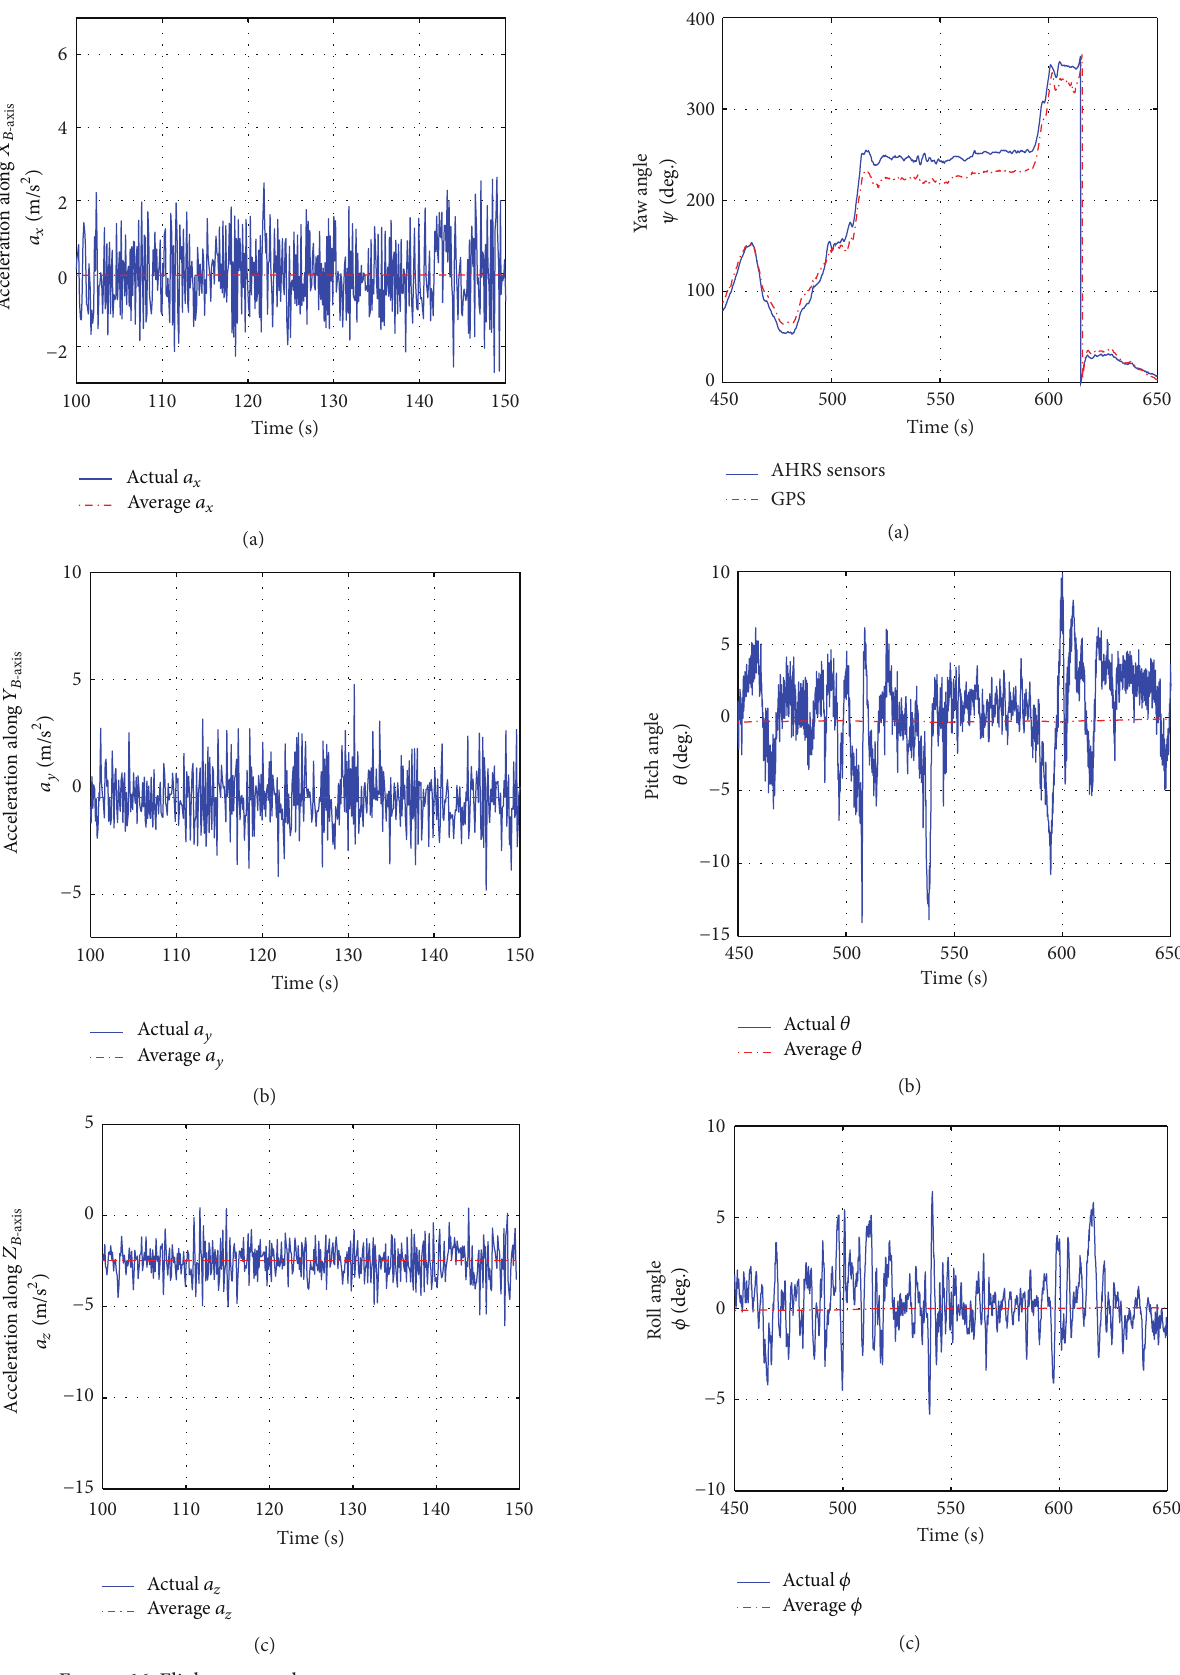
Figure 16: Flight test accelerometer outputs. Figure 17: Euler angles during flight